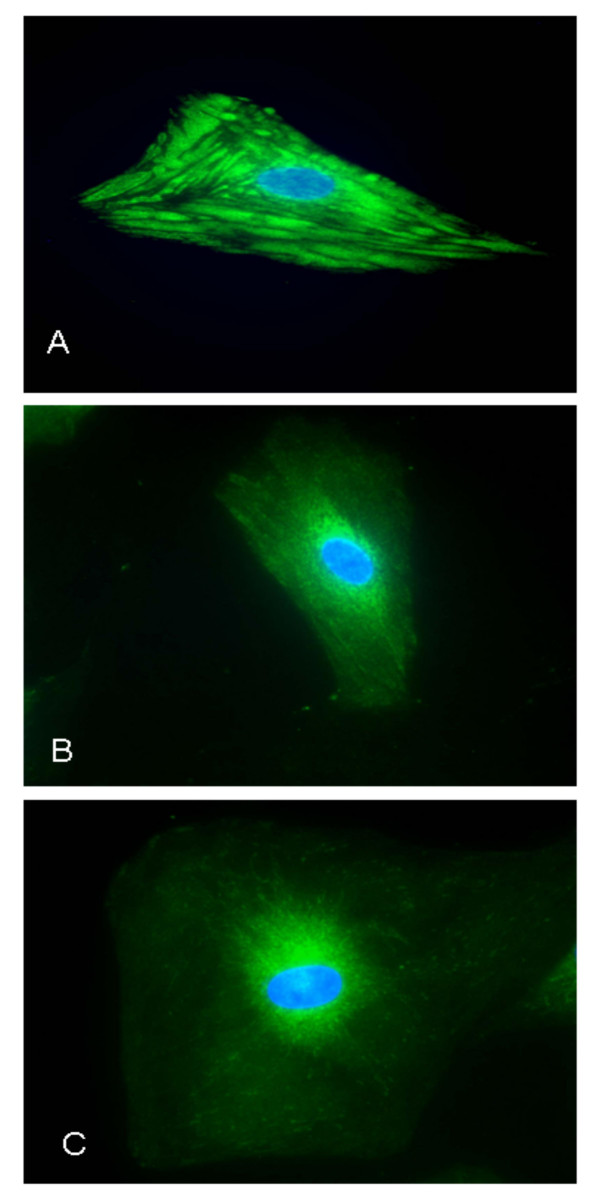
Cultured fibroblasts immunostained for collagen type I after 24 h exposure to 10-7M testosterone or 10-7M estrogen. A) Testosterone increased the amount of collagen present compared to control (C) as indicated by the increased number of secretory vesicles and the intensity of staining. B) Estrogen did not have any significant effect on collagen production.